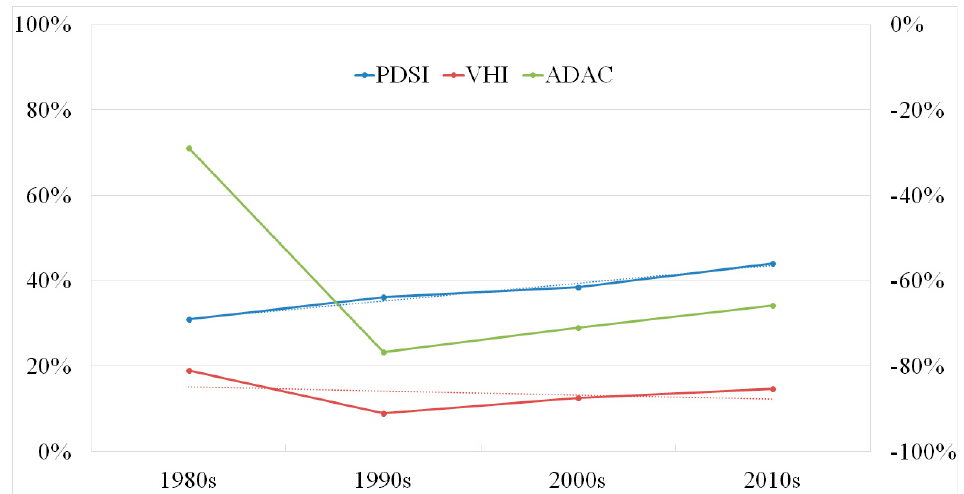
Figure 2. The decadal agricultural drought-affected area changes (ADAC) and drought-affected area identified by the PDSI and VHI during the period of March–May in 1981–2018 over the study area. The average ADAC values for Hebei, Henan and Shandong Provinces were − 52.5%, − 68.8% and − 63.2%, respectively. The annual change in ADAC in Henan Province had a significant decreasing trend with an annual decline rate of − 1.8% and generally weak decreasing trends in Hebei and Shandong Provinces. As shown in Figure 3, it is obvious that the fluctuating change in the decadal ADAC for Hebei and Shandong provinces decreased from 1980s to the lowest point at 1990s (Hebei in 1997 and Shandong in 1998) and then converted to an increase. However, the significant change in the ADAC in Henan Province was attributed to the reverse trends of increasing PDSI drought areas to decreasing VHI drought